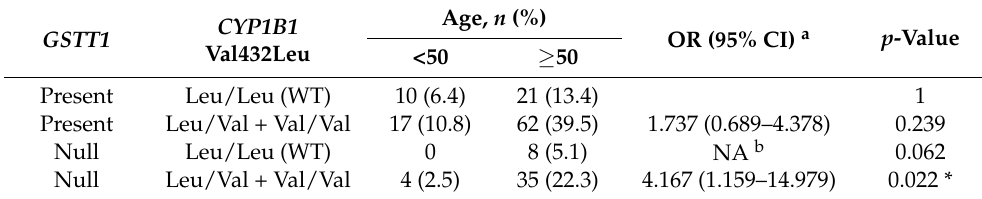
Table 4. Association between GSTT1 and CYP1B1 Val432Leu genotypes combination and patient age at diagnosis of breast cancer.